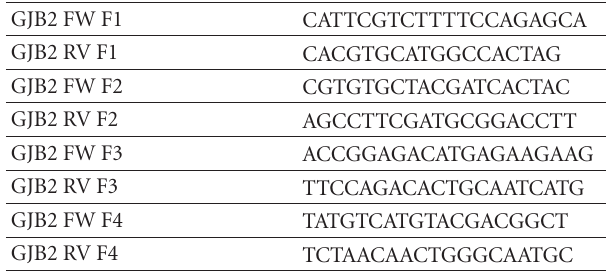
Table 1: GJB2 forward and reverse